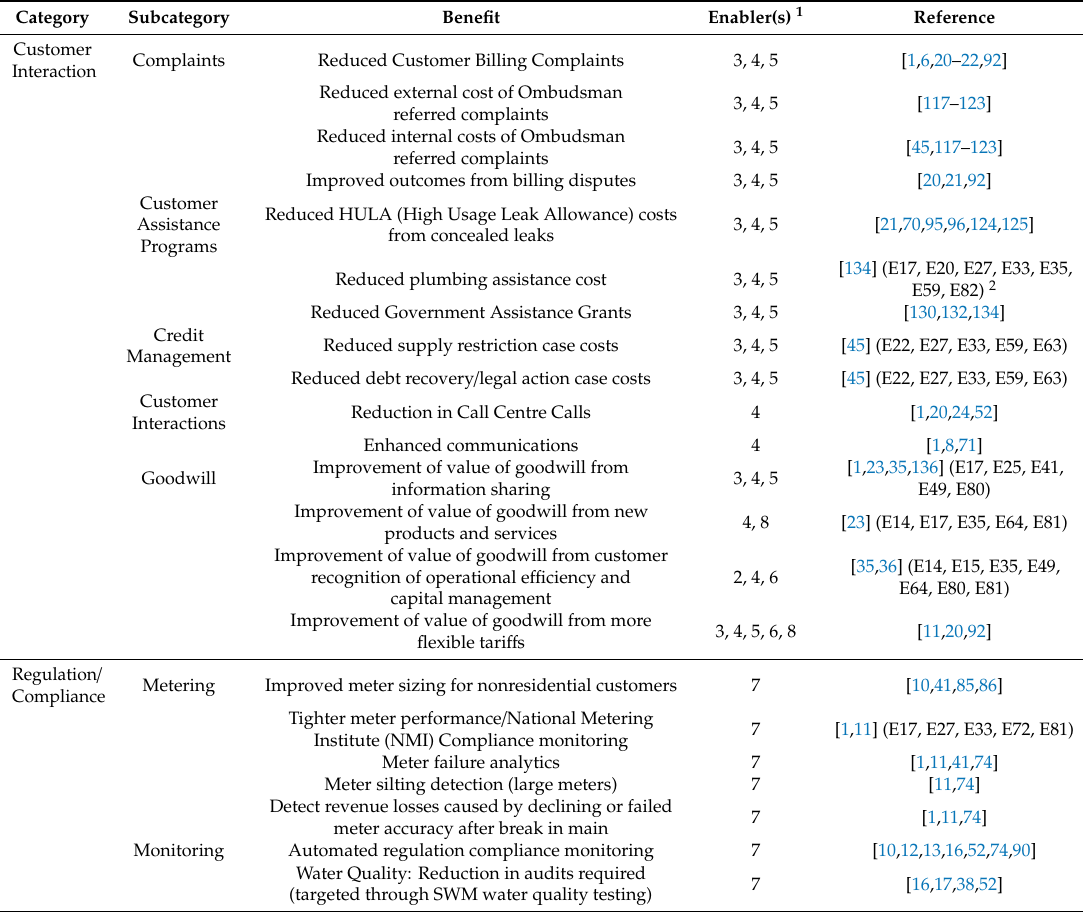
Table 4. The shared benefits available to both customers and water utilities from digital